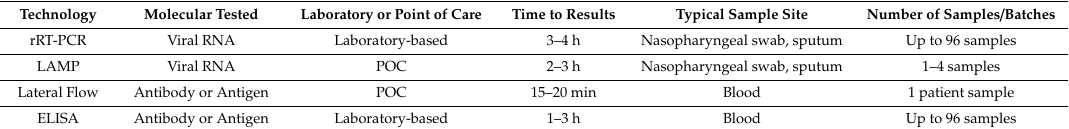
Table 1. Four main type of technologies used for identification of SARS-CoV-2.